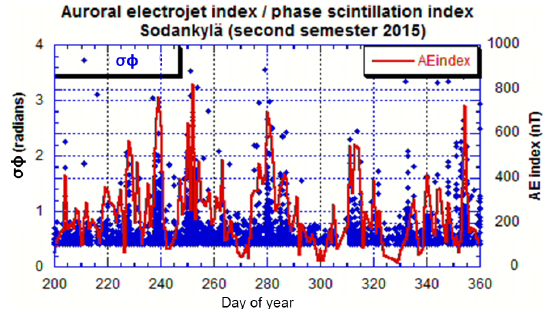
Figure 9. The coincidence of the auroral electrojet index with the phase scintillation index at high